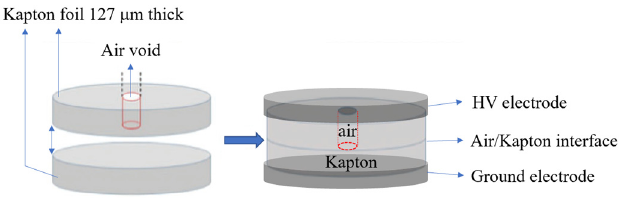
Figure 3. Specimen under test.